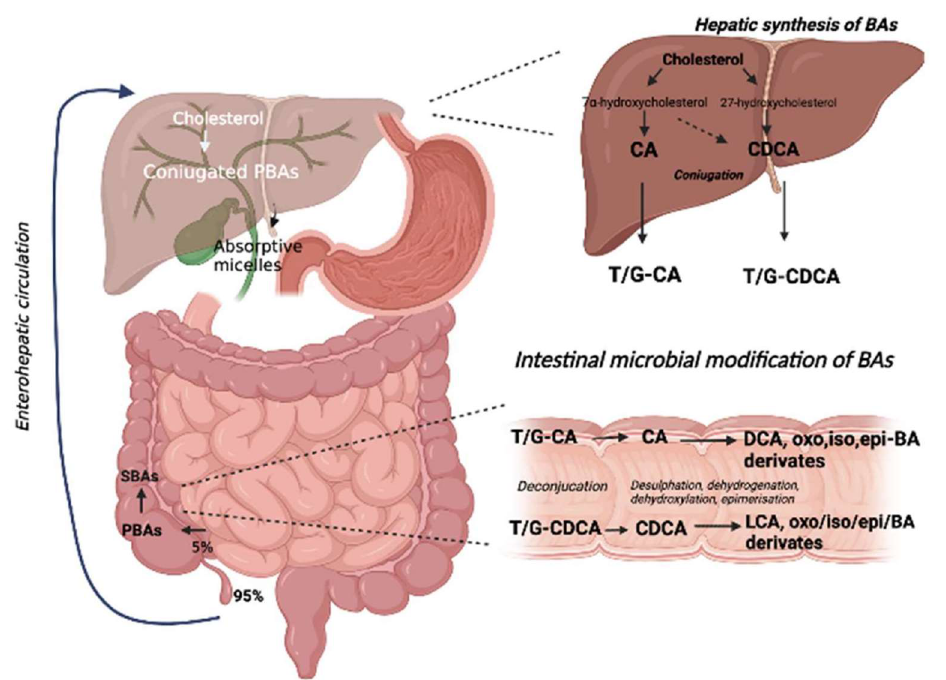
Figure 1. Biotransformation of biliary acids. BA metabolism starts with cholesterol and is converted into PBA in the liver (CA and CDCA). Subsequently, these are conjugated with glycine or taurine (T/G-CA and T/G-CDCA), stored in the gallbladder, and released in the intestine. Here, the conjugated BA are first deconjugated by intestinal bacteria and then metabolized through a series of chemical reactions (desulfation, dehydrogenation, dihydroxylation, and epimerization) catalyzed by bacterial enzymes to other types of SBA (DCA and LCA and oxo, iso, epi-BA derivates). 2. The Role of BA and Bile Acid Receptors (BARs) in the Pathogenesis of IBD and